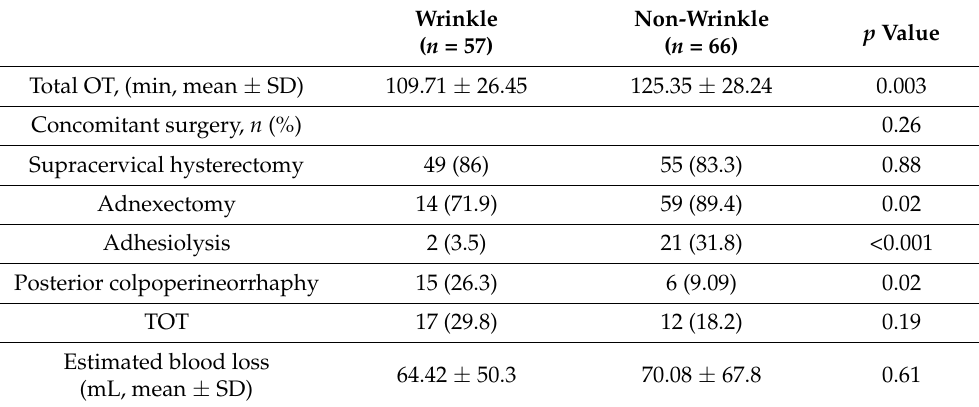
Table 2. Comparison of operative